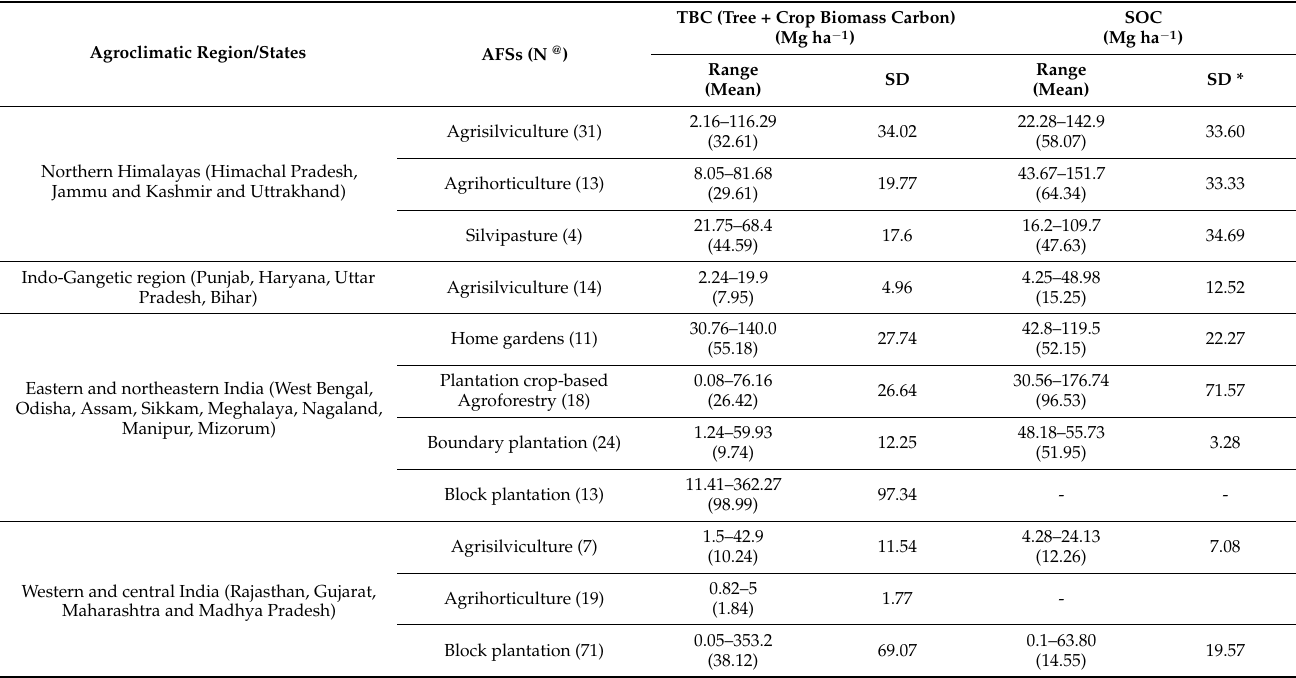
Table 2. Variation in carbon storage between AFS prevalent in different regions of the Indian